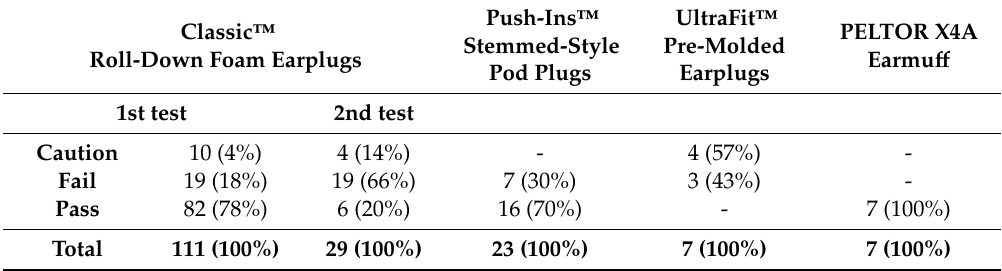
Table 6. Distributions of the PAR test results and percentages of the four types of HPD. Push-Ins Classic ™ Roll-Down Foam Earplugs